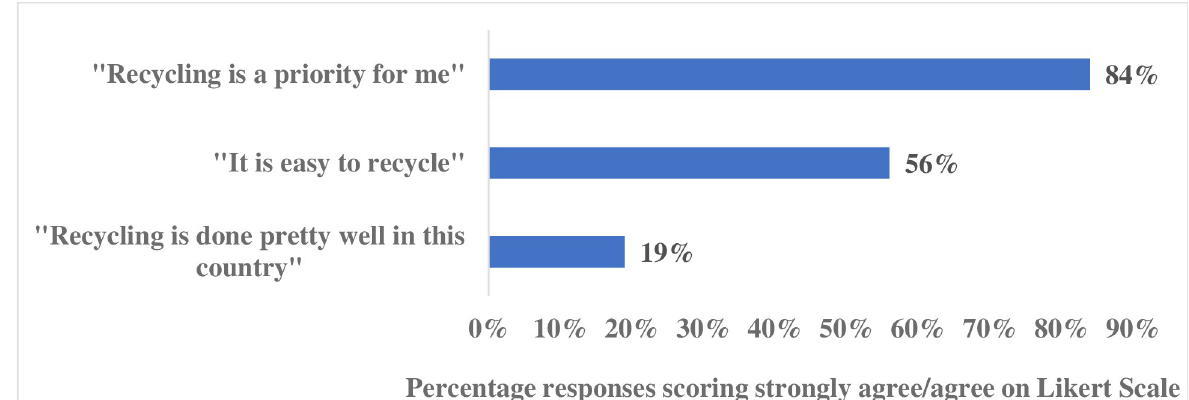
Fig 3. Responses to online survey selected items (recycling